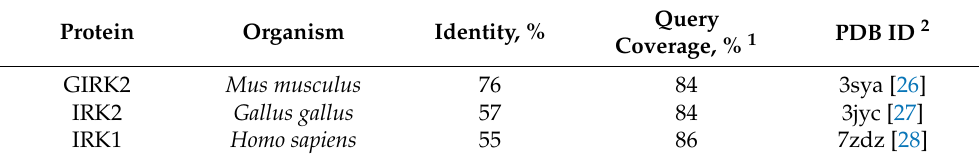
Table 1. Close homologs of human GIRK3 with known structures found with BLASTP.